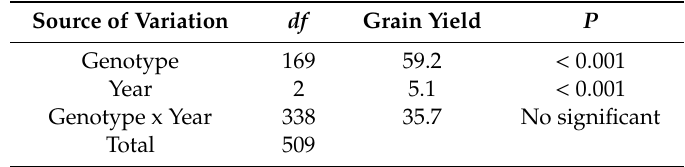
Table 3. Percentage of the sum of squares for grain yield of the ANOVA in the collection of 170 bread wheat landraces.